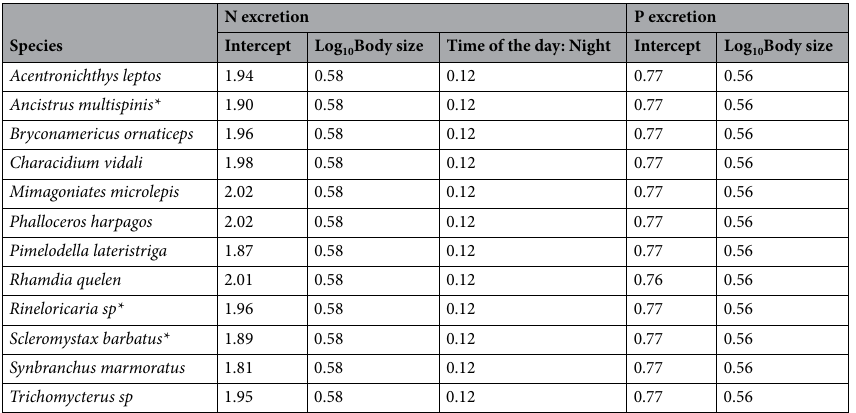
Table 4. Intercept and coefficient values (slope) from the relationship between body size (g) and N and P excretion rates (µg ind −1 h −1 ) for all fish species. *Armored catfish—fish of the family Loricariidae and Callichthyidae, named for the rows of overlapping bony plates that cover and protect their